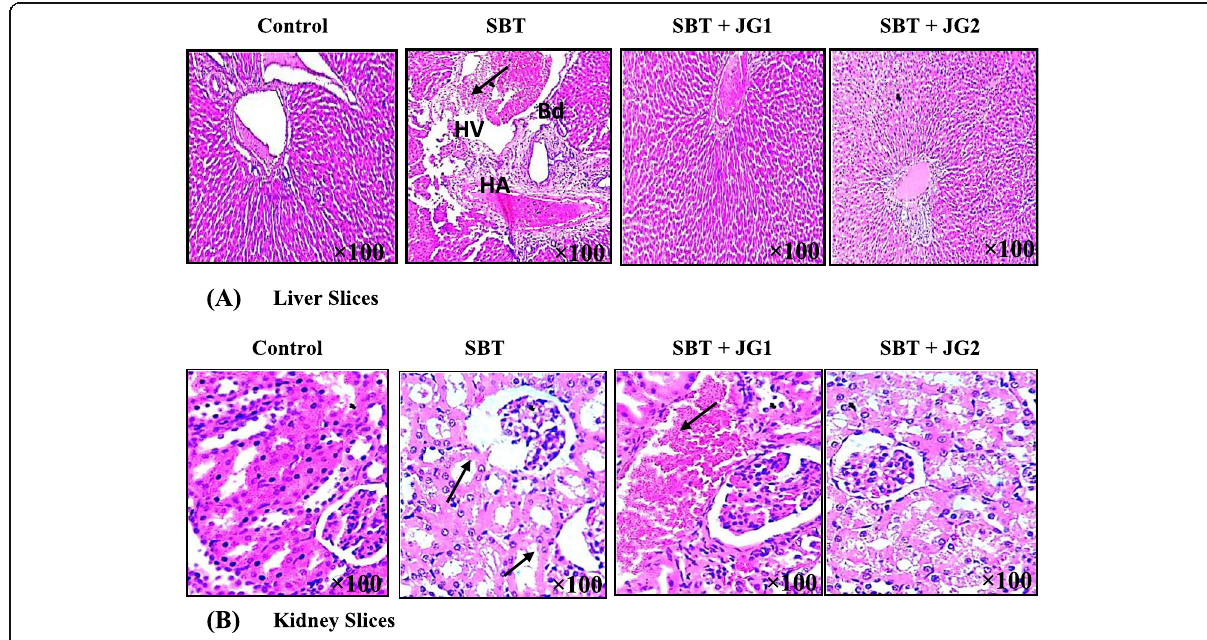
Fig. 5 Representative histological sections of panoramic views of the ( a ) liver and ( b ) kidney slices of the experimental rats. H & E stain ( × 100 magnification respectively ). Control: Animals were given distilled water only; SBT: Animals were treated with oral administration of sodium benzoate (200 mg/kg bw) only; SBT + JG1: Animals were given sodium benzoate (200 mg/kg bw) + J. tanjorensis extract (200 mg/kg b.w); and SBT + JG2:Animals were given sodium benzoate (200 mg/kg bw) + J. tanjorensis extract (500 mg/kg